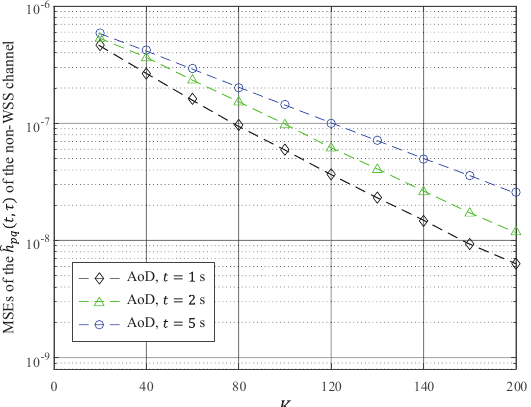
Figure 6. MSEs of the complex CIR of the non-WSSUS channel models for V2V communications with respect to the moving time of the MT and